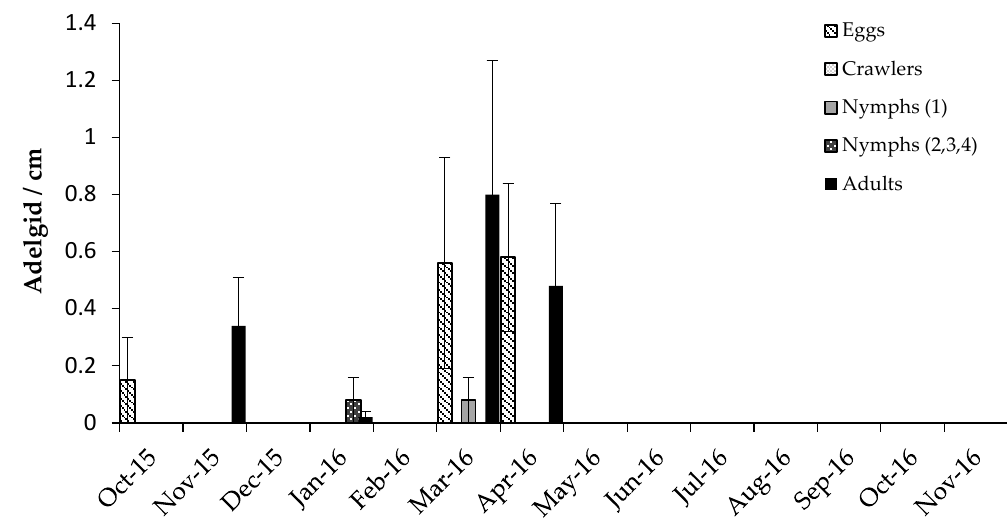
Figure 4. Mean number (±SE) of Adelges cooleyi collected by lifestage from Pseudotsuga menziesii in Tacoma, WA, USA (October 2015 – November 2016).